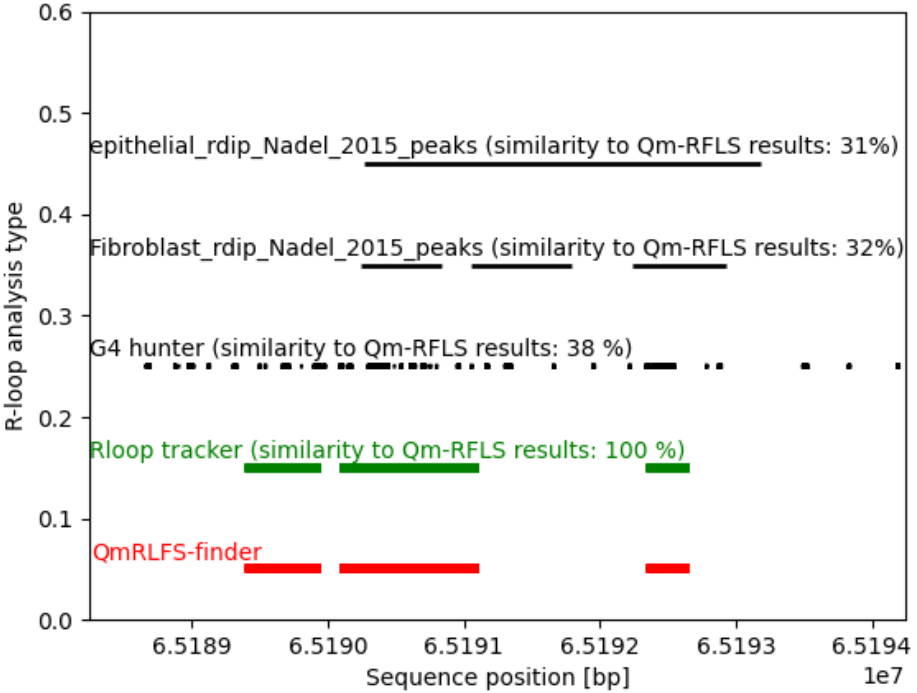
Figure 2. Example of an R-loop tracker comparison with QmRLFS finder algorithm on human chromosome 8.